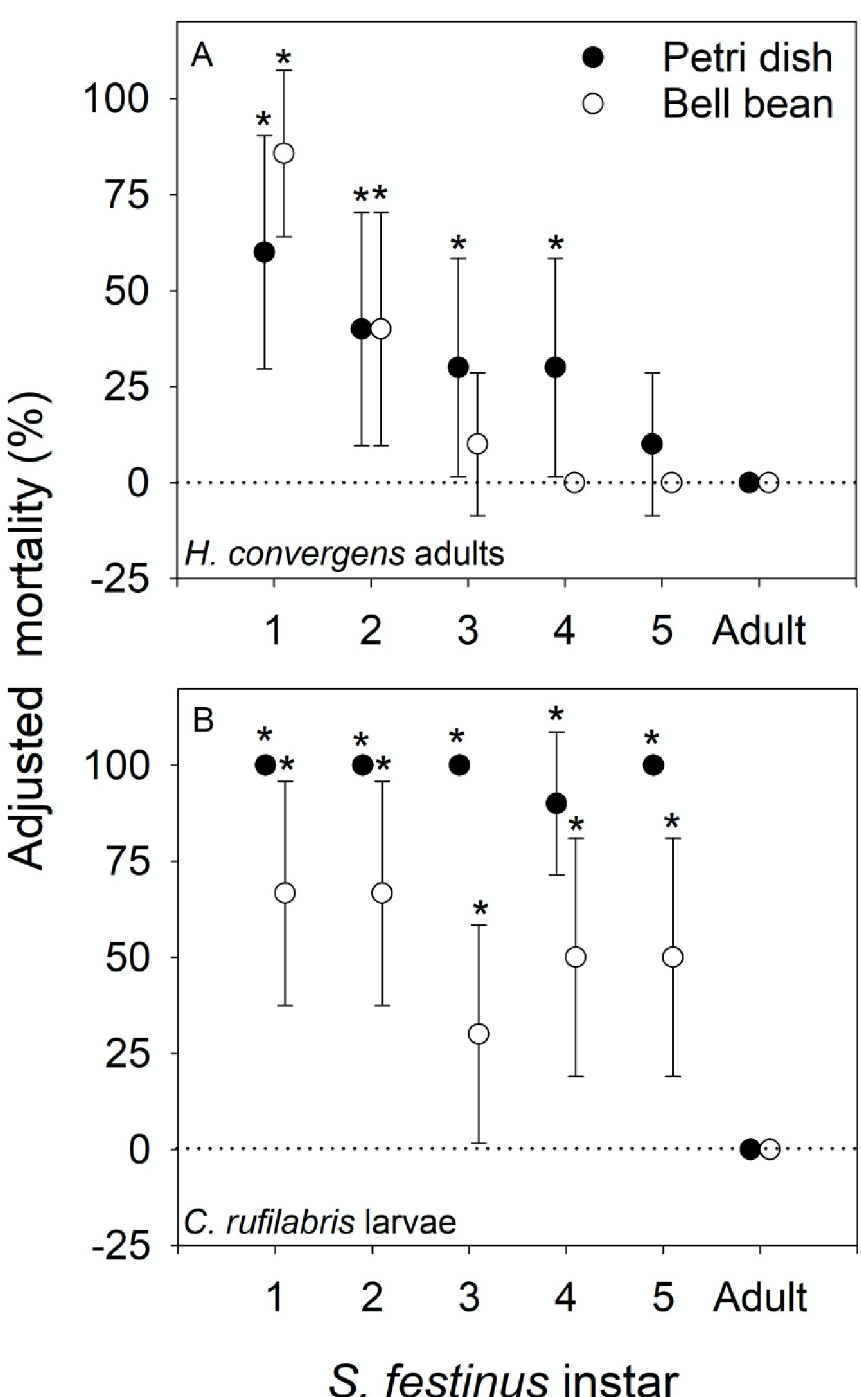
Fig 2. Results of petri dish and bell bean bioassays using A) H . convergens adults and B) C . rufilabris larvae. The percentage of prey that were killed in predator treatments was adjusted using Abott’s formula to account for background mortality observed in controls. Error bars represent 95% confidence intervals. Mortality was considered significant if it was positive and the confidence interval did not overlap with zero (indicated by an asterisk). Negative adjusted mortality values indicate greater mortality in controls than in predator